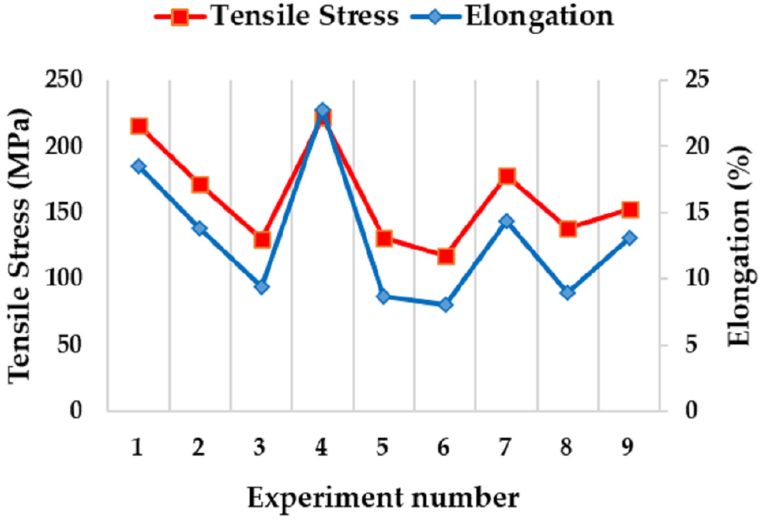
Figure 12. The average tensile stress values and elongation (%) of nine samples.